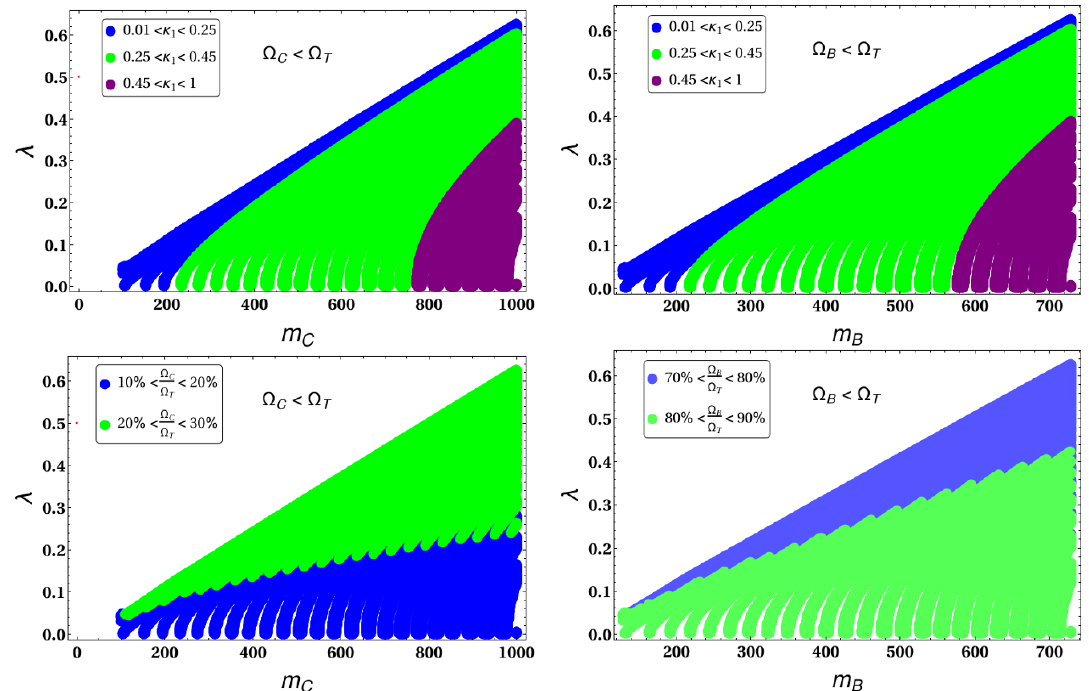
Figure 7 . (cid:21) vs m C (left) and (cid:21) vs m B (right) for satisfying relic density 0 : 1175 < (cid:10) T < 0 : 1219. [Top panel:] Di(cid:11)erent choices of (cid:20) 1 are shown in di(cid:11)erent colours: 0 : 01 (cid:0) 0 : 25 (blue), 0 : 25 (cid:0) 0 : 45 (green), 0 : 45 (cid:0) 1 : 0 (purple). [Bottom panel:] Relative contributions of individual DM candidates to total relic abundance have been shown in di(cid:11)erent